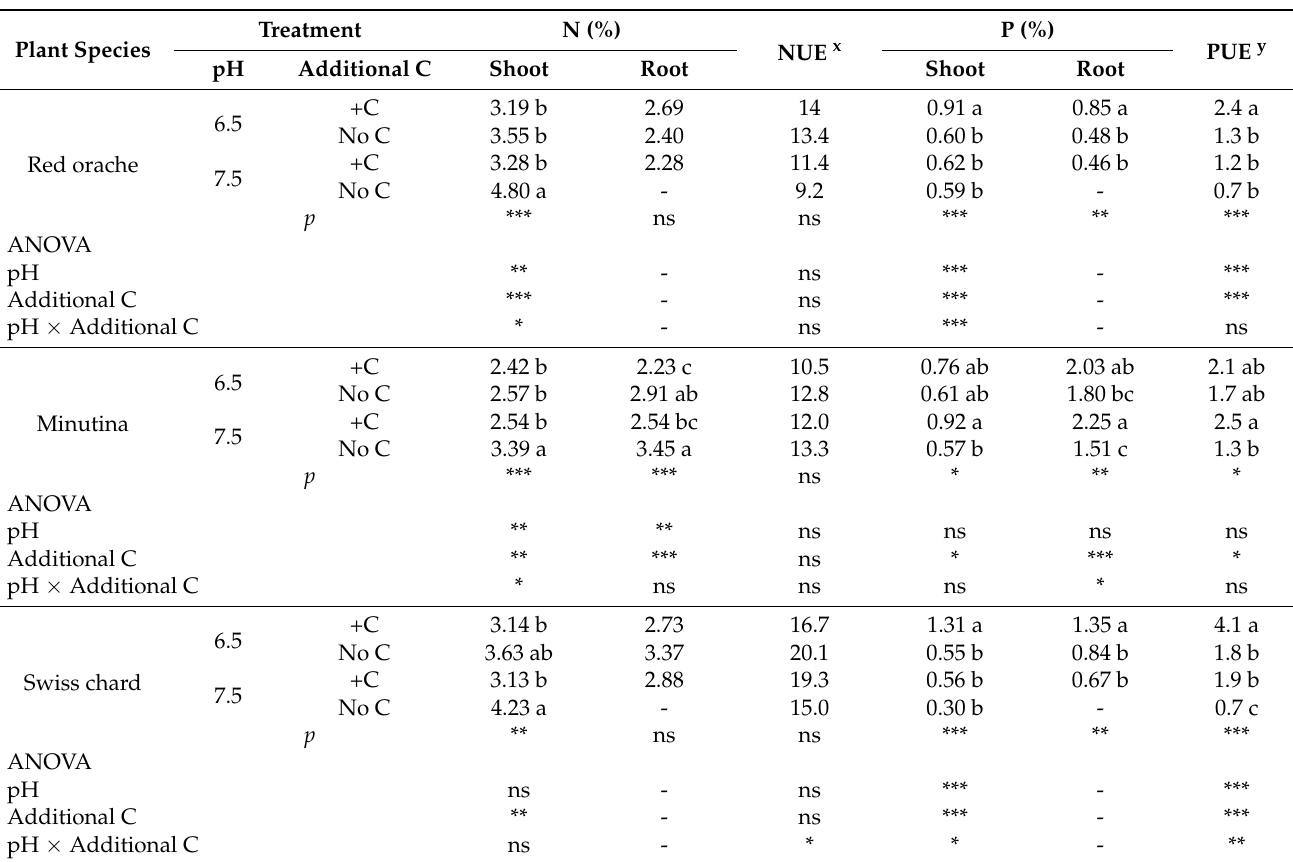
Table 6. Average nutrient content and nutrient use efficiency of red orache, minutina, and Swiss chard from the first